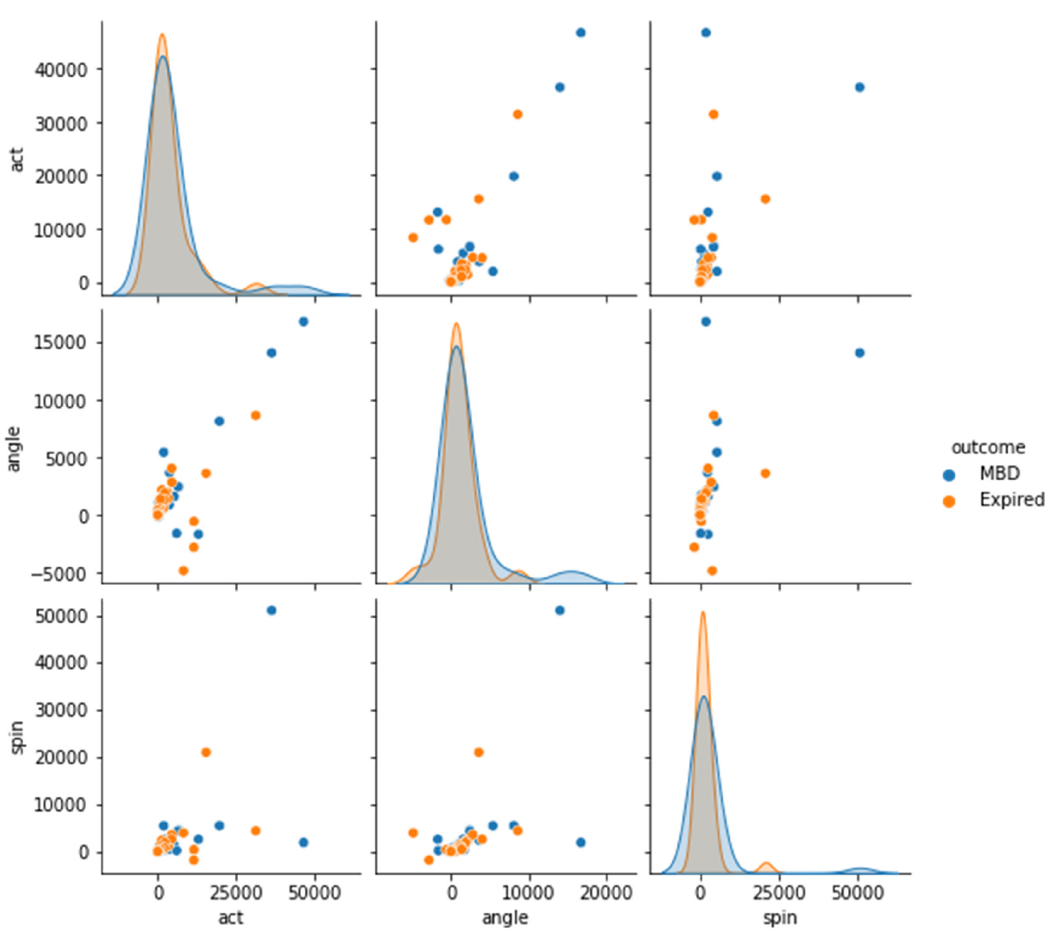
Figure 9. Differential representation between the ACT, angle, and spin at 12 h in order see the relationship between two variables (MBD and expire).